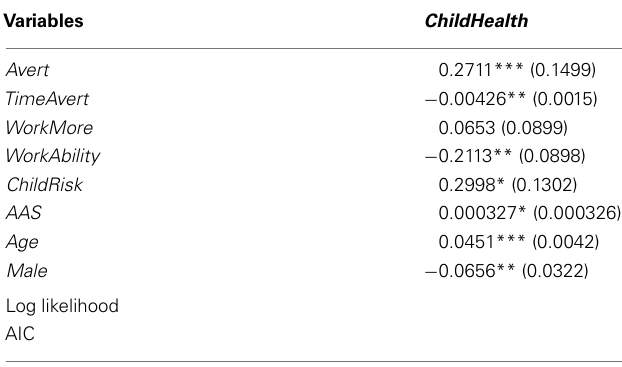
Table 3 | Coefficient estimates ( n = 2,190)